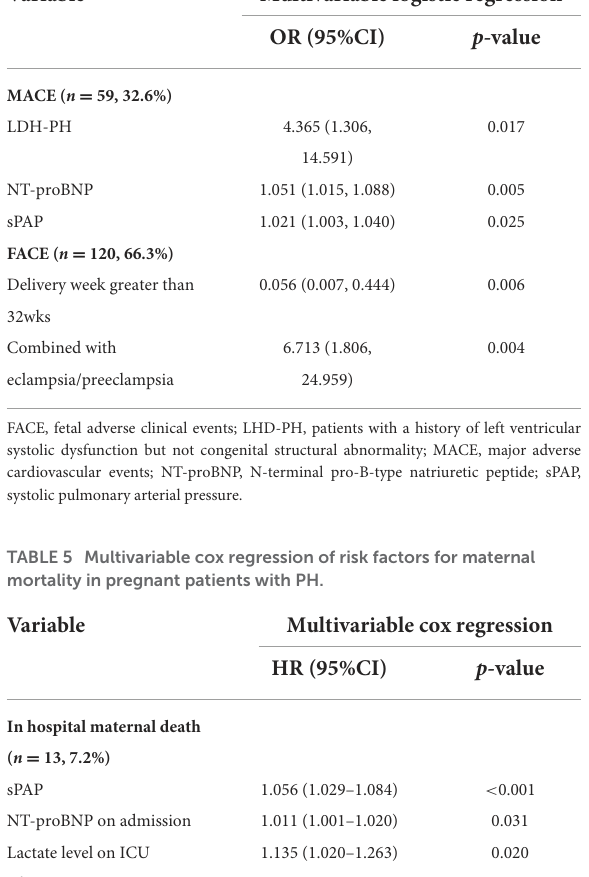
TABLE 4 Multivariable logistic regression of risk factors for MACE and FACE in pregnant patients with PH diagnosed via echocardiography. Variable